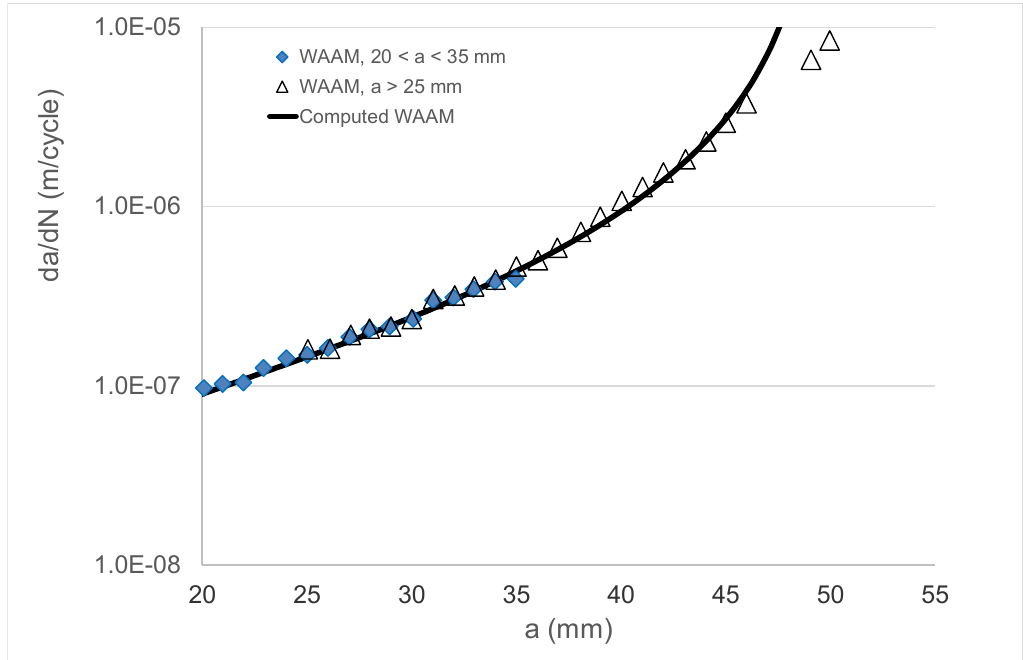
Figure 12. Comparison between the measured and computed growth rate ( da/dN ) versus crack length ( a) curves for the wire and arc additive manufactured (WAAM) test specimens.